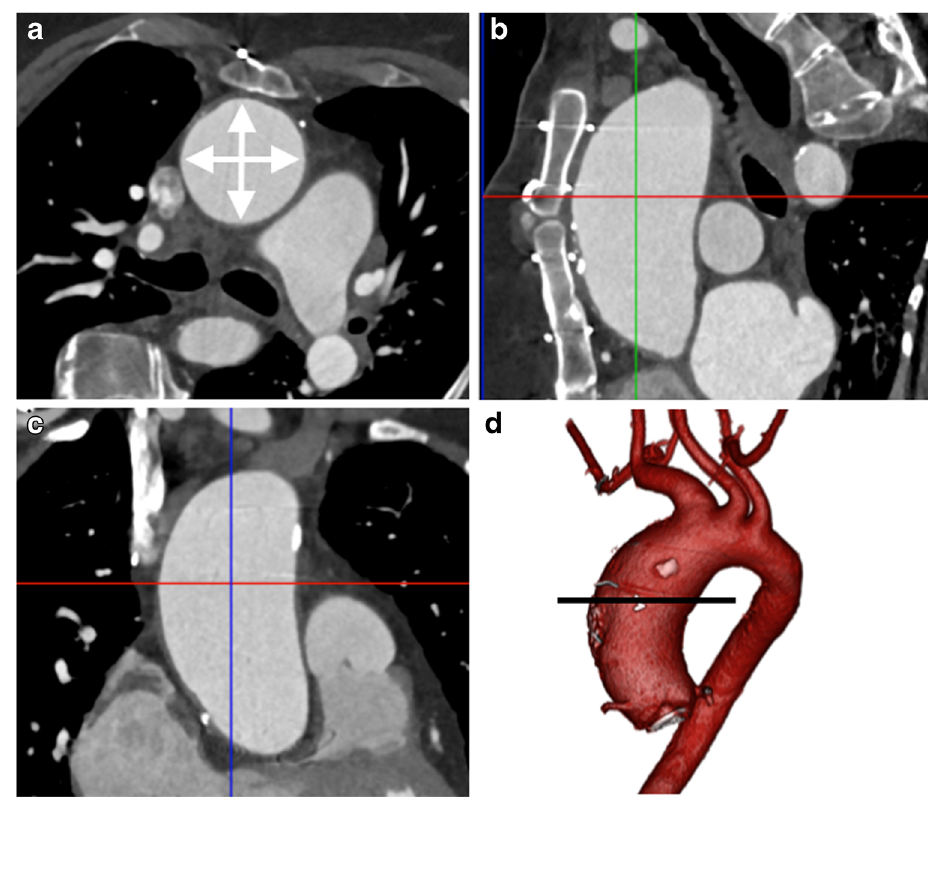
Fig. 2 A 45-year-old man with Marfan ’ s syndrome post aortic valve replacement with a fusiform ascending aortic aneurysm. Measurement of the ascending thoracic aorta dimension ( double arrows ) in a plane double oblique to the vessel centerline ( a ) with sagittal ( b ) and coronal ( c ) MPRs demonstrating the plane of mea- surement ( red lines ). Three- dimensional segmented VR im- age of the thoracic aorta ( d ) dem- onstrates the site of measurement ( line